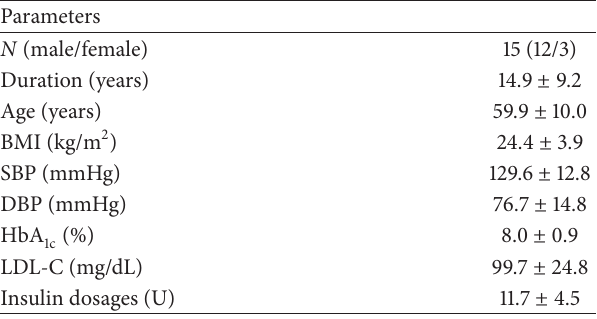
. HbA 1 decreased significantly com- c c